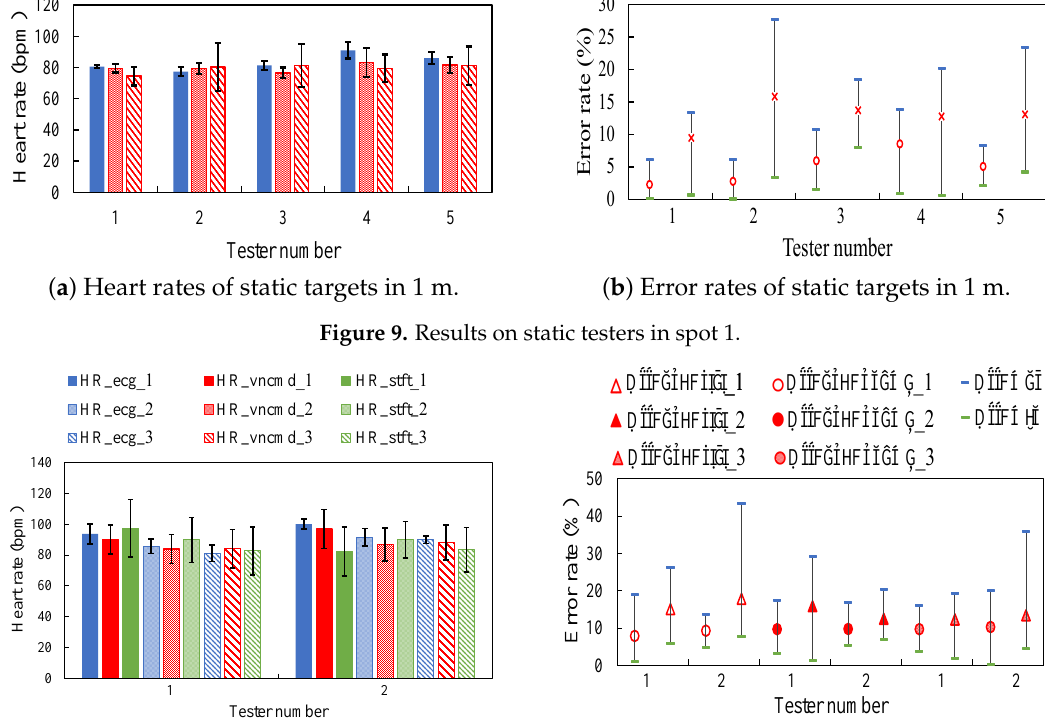
( b ) Error rates of static targets in three positions. Figure 10. Results on static testers in spot